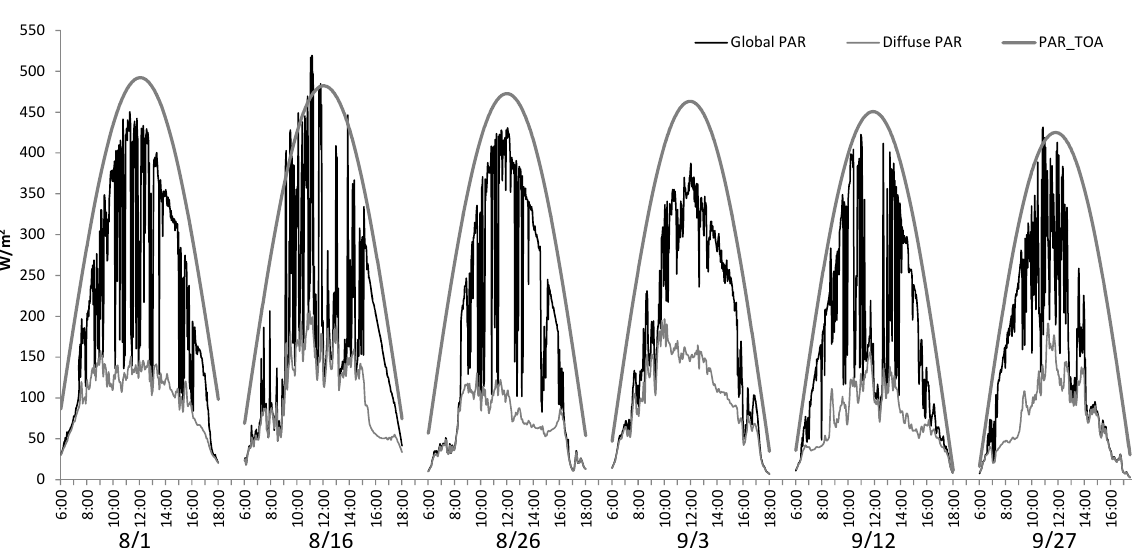
Fig.1 The measured global, diffuse PAR and the horizontal extraterrestrial PAR (TOA) with instantaneous value on six days selected as sunny day for